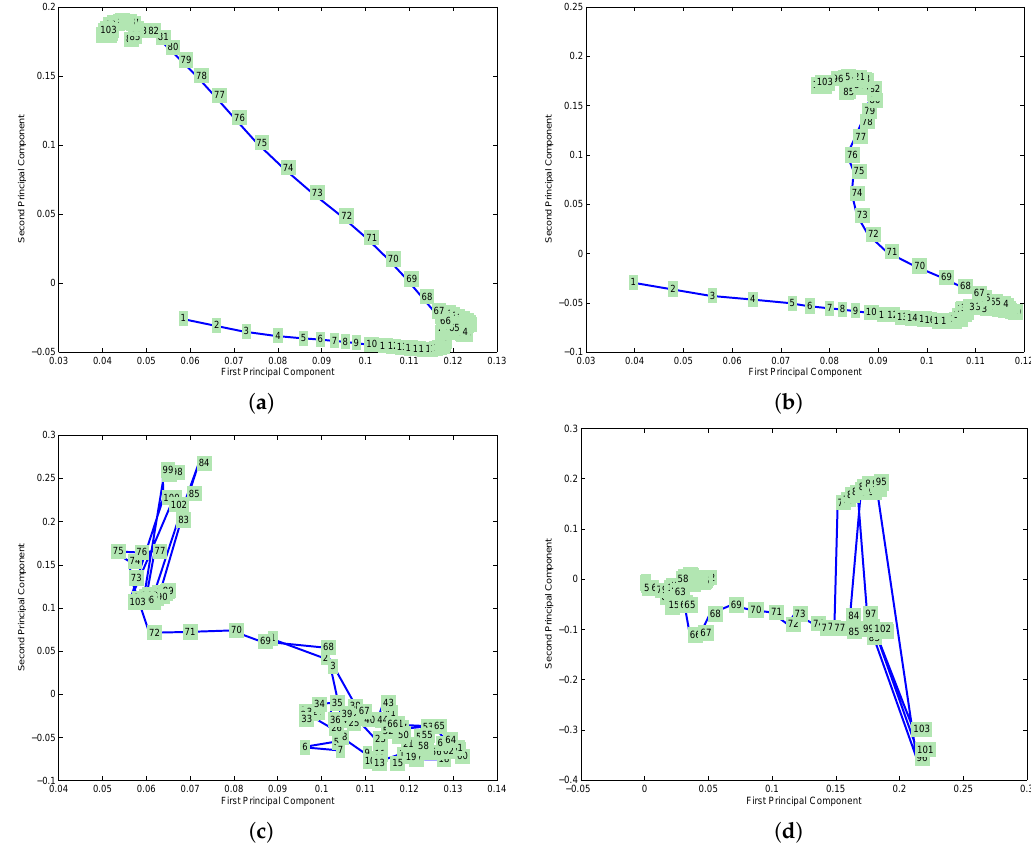
Figure 13. Hyperspectral band projection into the first two eigenvectors ( i.e. , image manifold) from Pavia hyperspectral image: ( a ) classical PCA on spectral bands; ( b ) scale-decomposition MorphPCA; ( c ) pattern spectrum MorphPCA; ( d ) distance function MorphPCA.